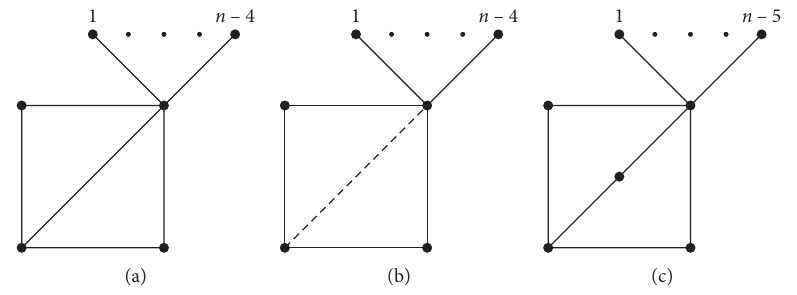
. (b) C − . (c) C + . (d) S 0 . (e) S 1 n,n . 3 3 4